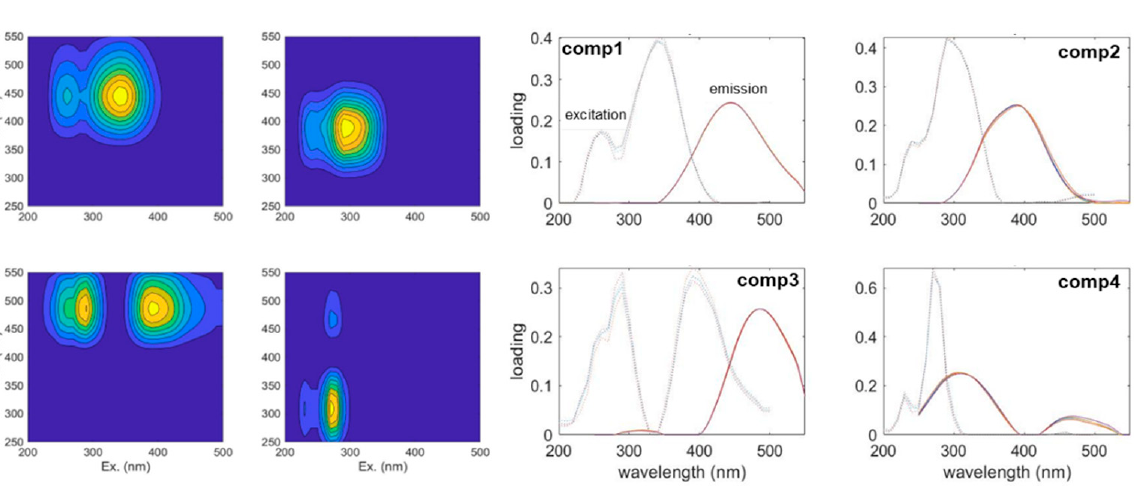
Figure 7. PARAFAC analysis process and result (taking FU dataset as an example).